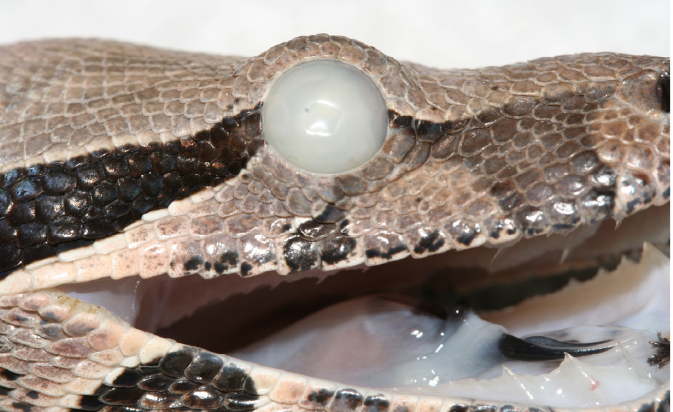
Figure 29. Subspectacular infection associated with bacterial infection in a boa constrictor ( Boa constrictor ). The subspectacular space is filled with flocculent exudate.